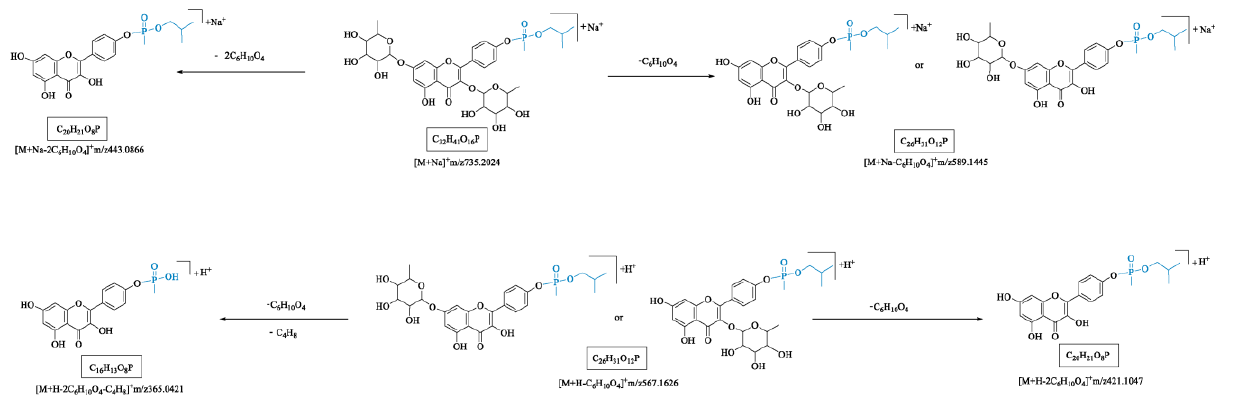
Figure 14. Possible fragmentation pathways of product ions for compound 7.